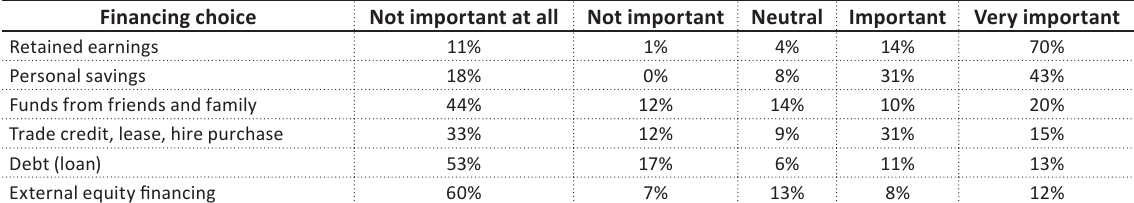
Table 5. Financing choice of firms after being established